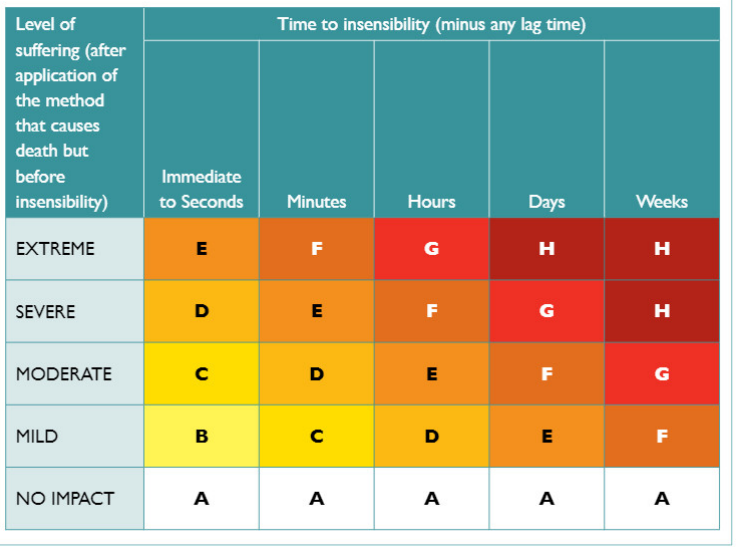
Figure A2. Overall impacts of the mode of death for kill traps (Part B). Reprinted from A model for assessing the relative humaneness of pest animal control methods. Second edition. (p. 52), by T. Sharp and with authors’